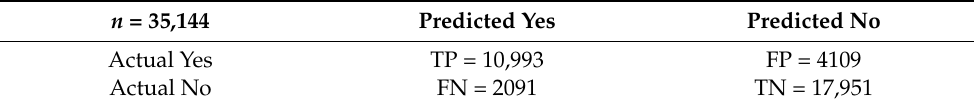
Table 3. Group model confusion